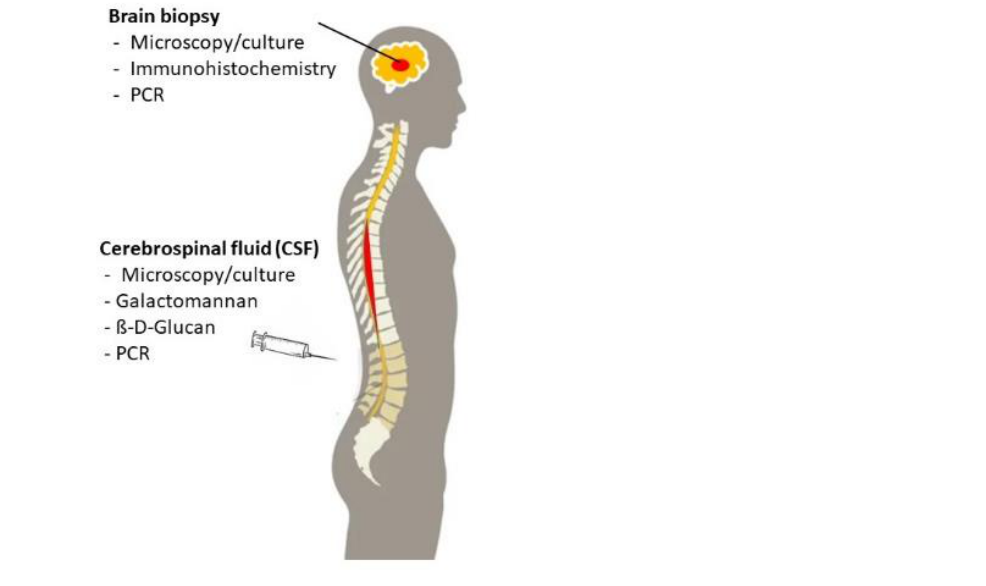
Figure 6. Diagnostic tools for brain biopsy specimens and for cerebrospinal fluid.